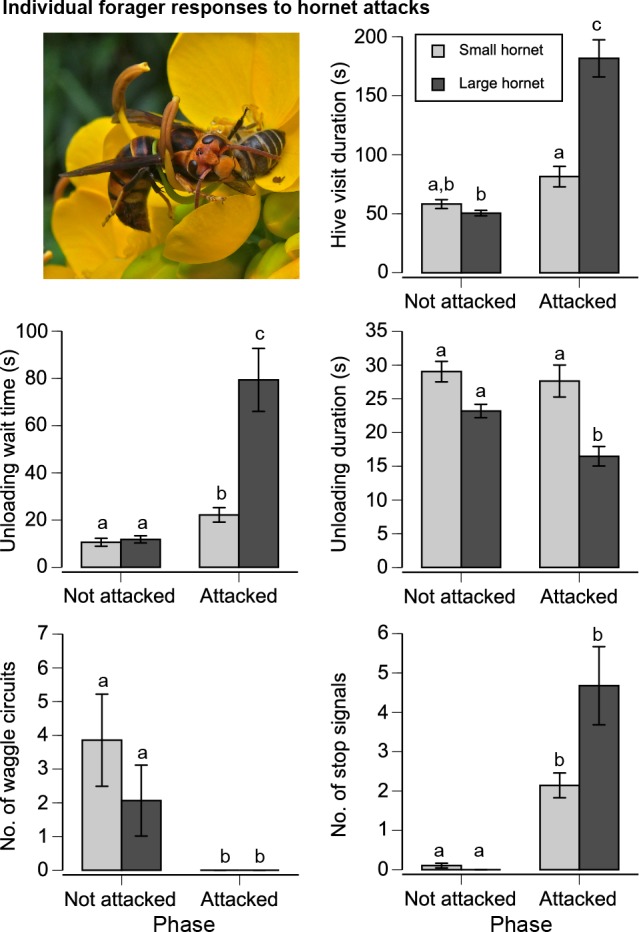
Effect of small and large hornet attacks at the food source on the individual behavior of foragers in the nest (from three bee colonies, 56 bees attacked by small hornet and 72 bees attacked by large hornet).Standard error bars are shown. Different letters indicate significant differences (Tukey’s HSD test, p < 0.05). Photo shows V. velutina (small hornet) killing an A. cerana forager on a Cassia surattensis inflorescence.